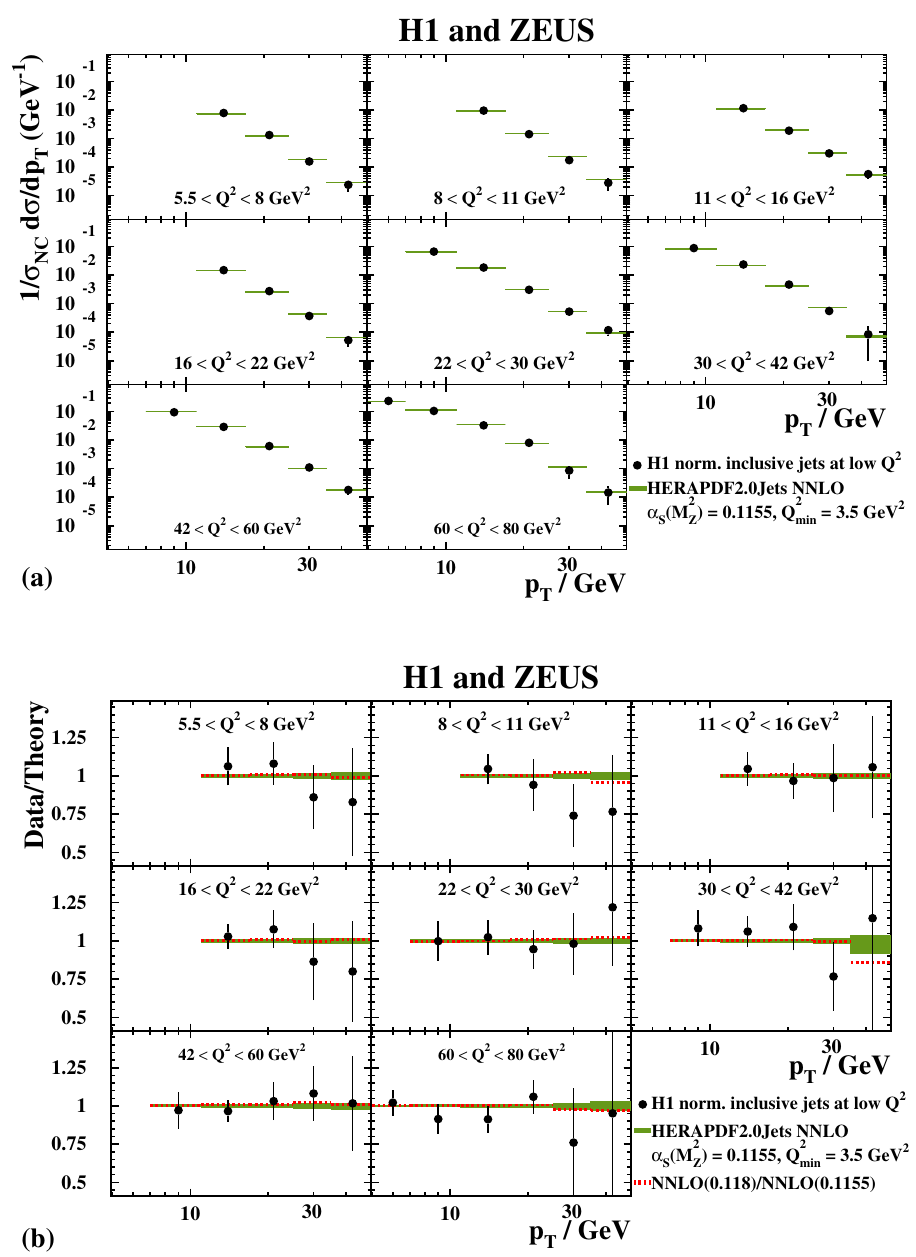
Fig. 15 a Differential jet-cross-section predictions, d σ/ d p T , based on HERAPDF2.0Jets NNLO with α s ( M 2 between 5.5 and 80GeV 2 compared to H1 data normalised to neutral current (NC) inclusive cross sections [14]. Only data used in the fit are shown. b Measured normalised cross sections divided by predictionst